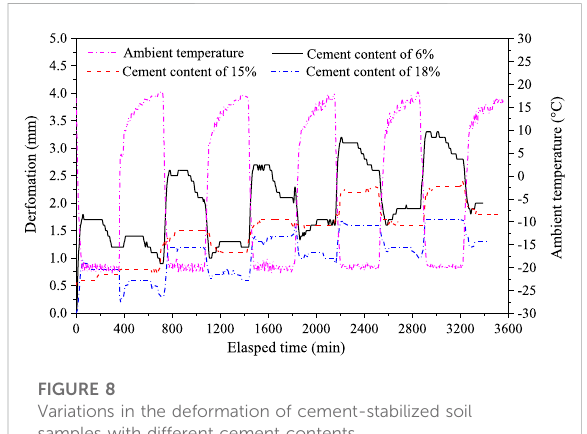
FIGURE 9 Variationsinthedrydensityofcement-stabilizedsoilsamples with different cement